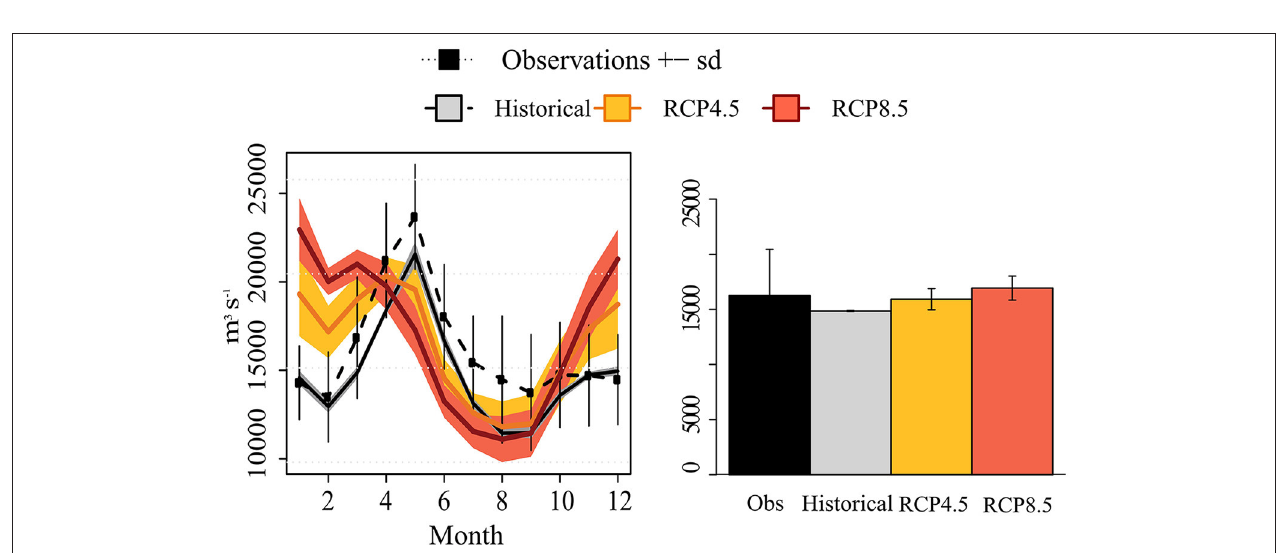
FIGURE 4 | Ensemble mean, monthly (left), and annual (right) runoff (in m 3 s − 1 ) for the Baltic Sea calculated from four hydrological model simulations: historical period (1976–2005) (solid black line in the left panel and gray bar in the right panel) and future period (2069–2098) according to RCP 4.5 (orange) and RCP 8.5 (red) scenarios, respectively. The colored shaded areas in the left panel denote the range between minus and plus one standard deviation among the ensemble members. In addition, observations and their standard deviations are shown (dashed black line with squares and vertical thin bars in the left panel and black bar in the right